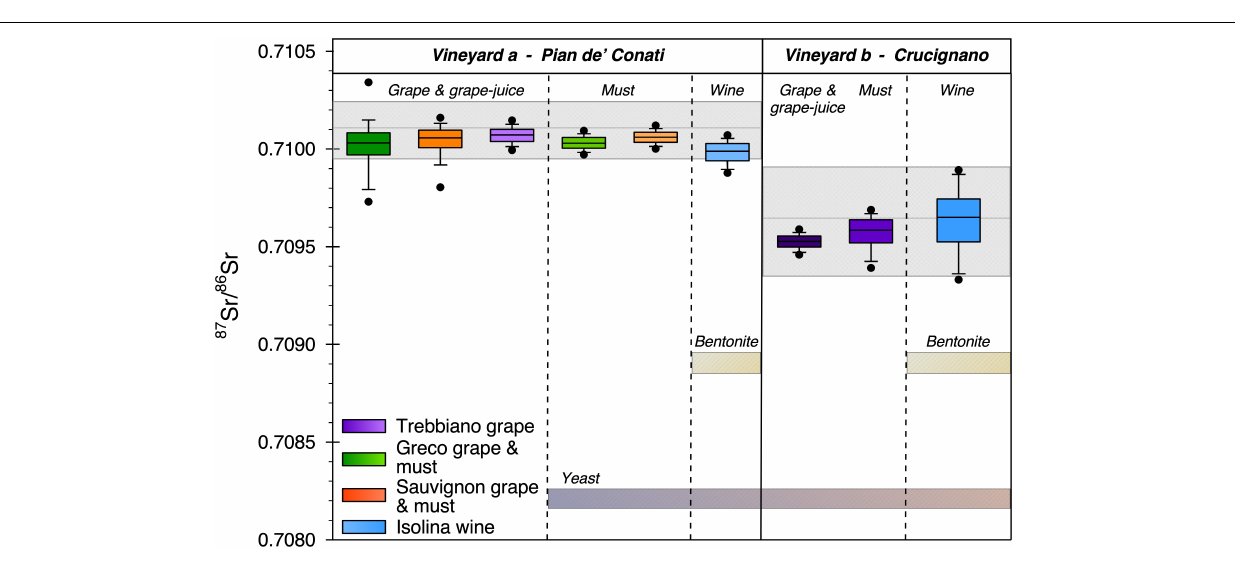
FIGURE 7 | 87 Sr/ 86 Sr values in grape, juice, musts, and wine for the Isolina wine (from the 2006 to the 2015 vintage years). Isolina wine is composed by a blending of Greco, Sauvignon, and Trebbiano varieties. Among these grape varieties, Greco and Sauvignon are exclusively grown in the area of Pian de’ Conati (vineyard a ), whereas the Trebbiano derive mostly from the Crucignano area (vineyard b ). The final value of the wine depends on the percentages of the three musts employed year by year and on the geologic provenance of the soil on which the grape grew. The box plot features are reported through text and in the caption of Figure 2 . The gray patterns represent the whole range of variability of the soil bioavailable fraction, respectively, in the Pian de’ Conati ( a ) and the Crucignano ( b ) area. The shaded bars represent the isotopic range of the analyzed additives, bentonite, and yeast, respectively. The length of the bars depends on the wine-making step in which such additives are introduced, thus the different matrix in which we investigated their potential